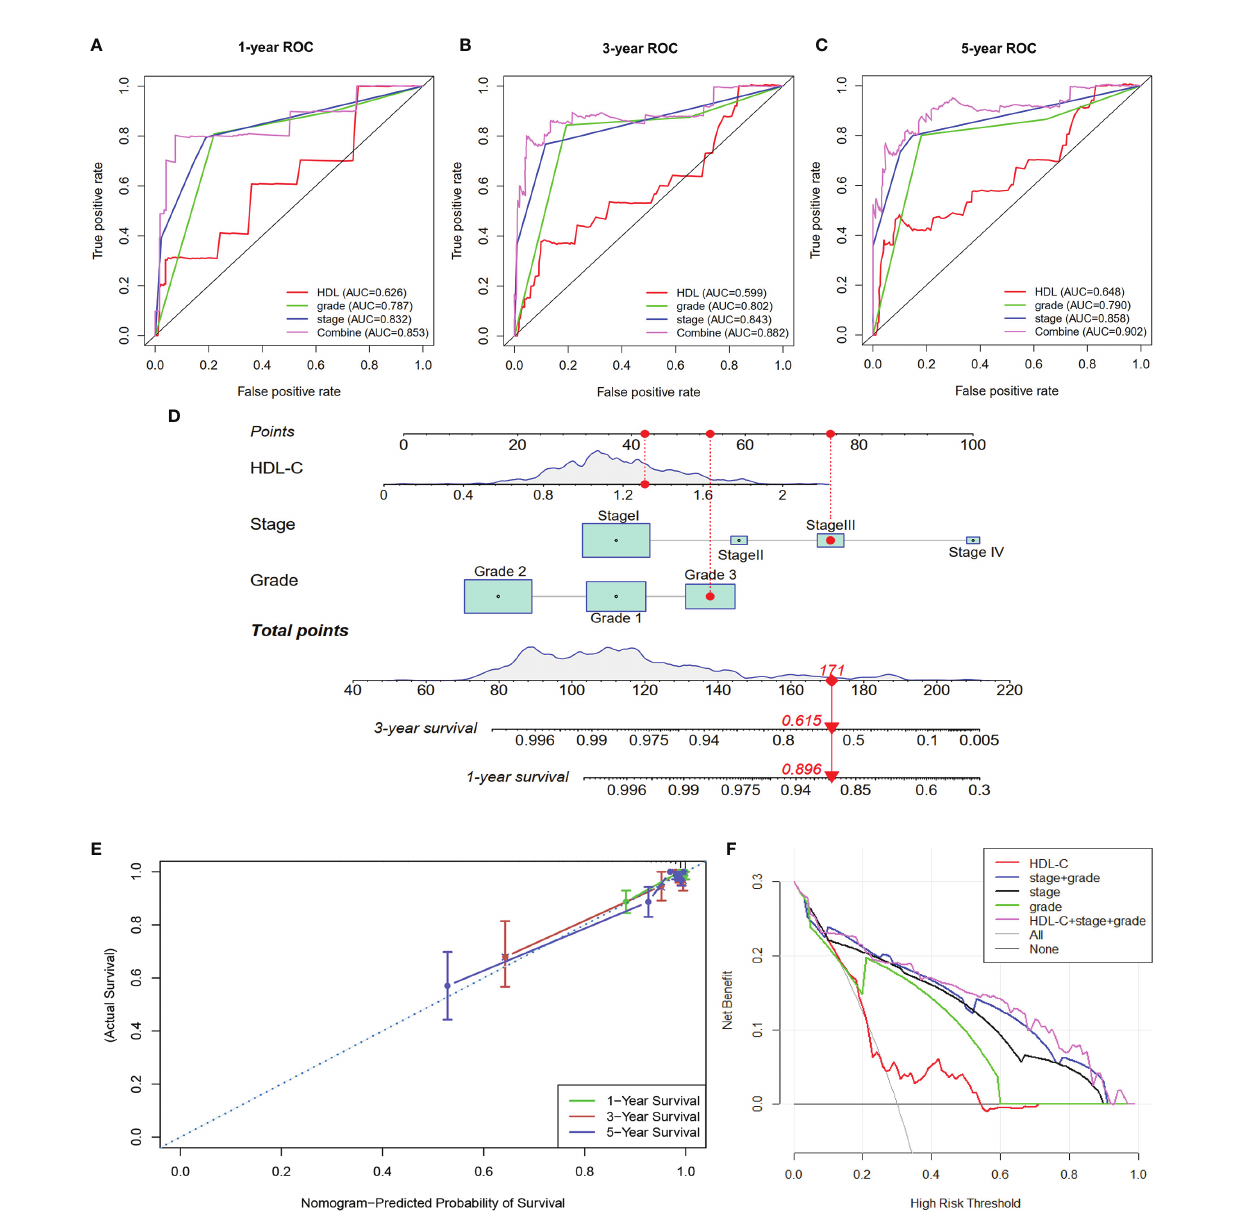
FIGURE 2 | ( A – C ) ROC analysis were performed to evaluate the ability of HDL-C in predicting EC patient prognosis at 1-, 3-, and 5-years. ( D ) A nomogram was constructed based on HDL-C, grade, and stage to predict 1- and 3-year survival rates of EC patients. ( E, F ) Calibration curve analysis and DCA analysis of the